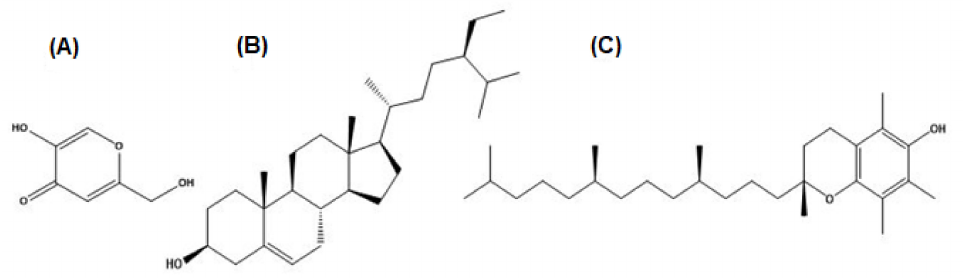
Figure 11. Structures of the GC-MS profiled compounds and kojic acid docked with tyrosinase. ( A ) Kojic acid, ( B ) beta-sitosterol, and ( C ) vitamin E.